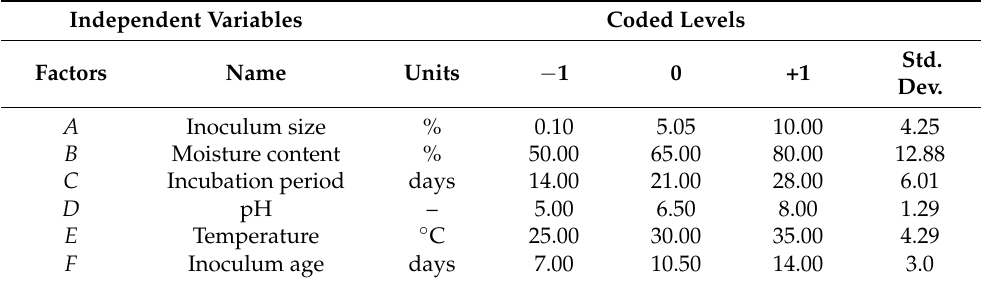
Table 1. Experimental range, level, and code of independent variables in a two-level FFD. Independent Variables Coded Levels